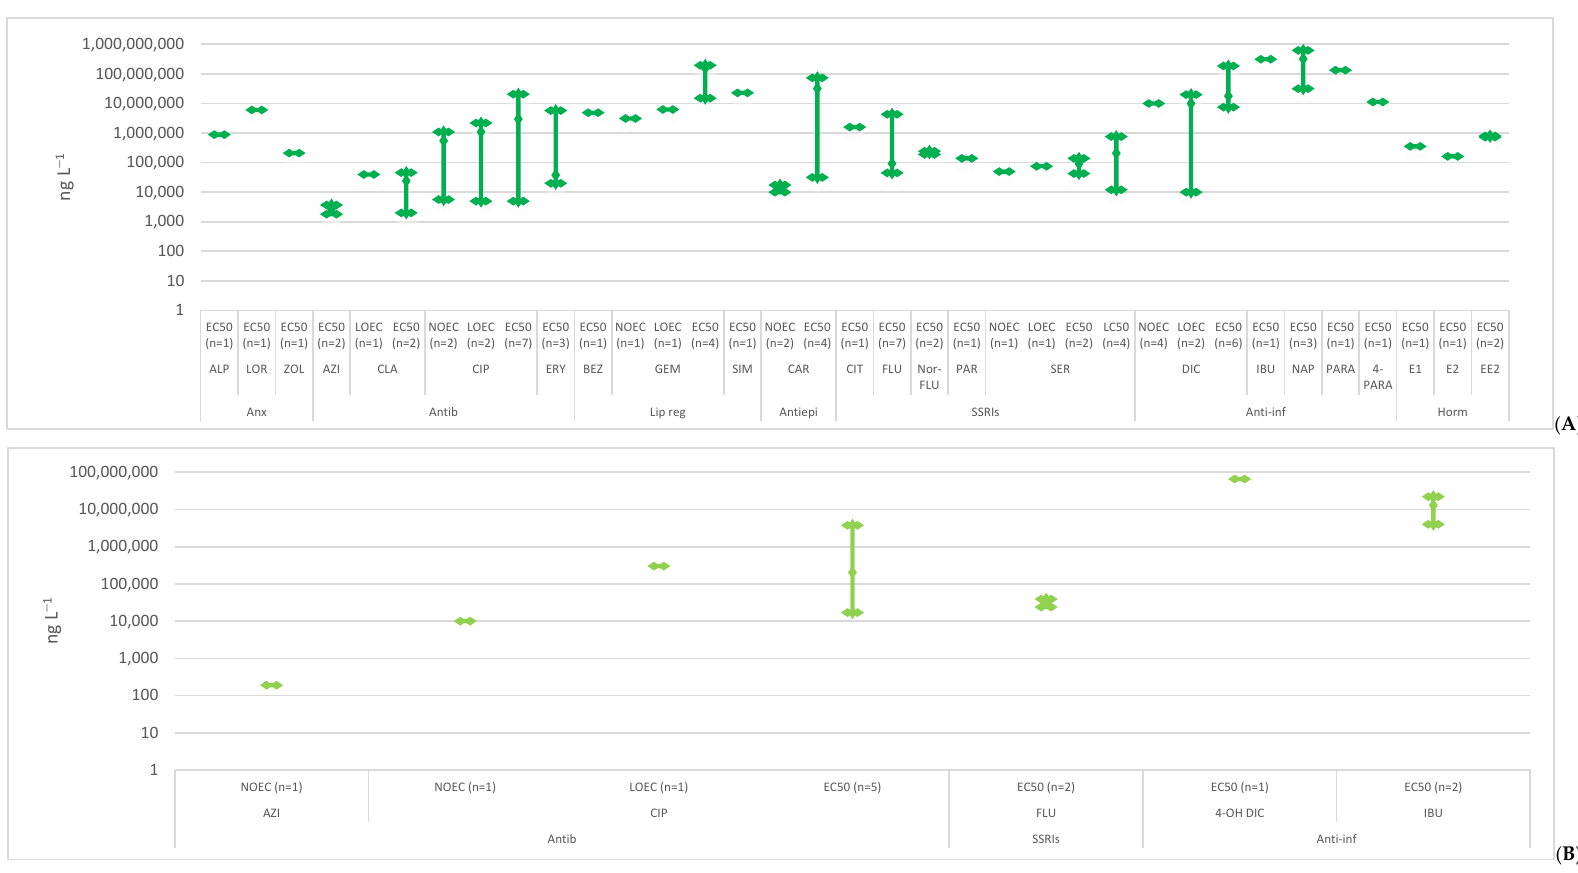
Figure 1. Median, maximum and minimum concentration values reported for acute ( A ) and chronic ( B ) toxicity concerning algae. (Anx—anxiolytics; Antib—antibiotics; Lip reg—lipid regulators; Antiepi—antiepileptics; SSRIs—Selective serotonin reuptake inhibitors; Anti-inf—anti-inflammatories; Horm—hormones)